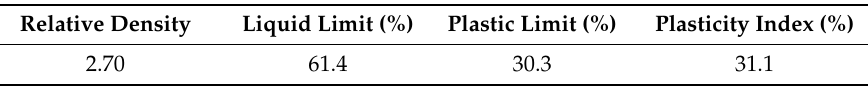
Table 4. Physical properties of Guangxi expansive soils (data after Miao et al. [42]). Relative